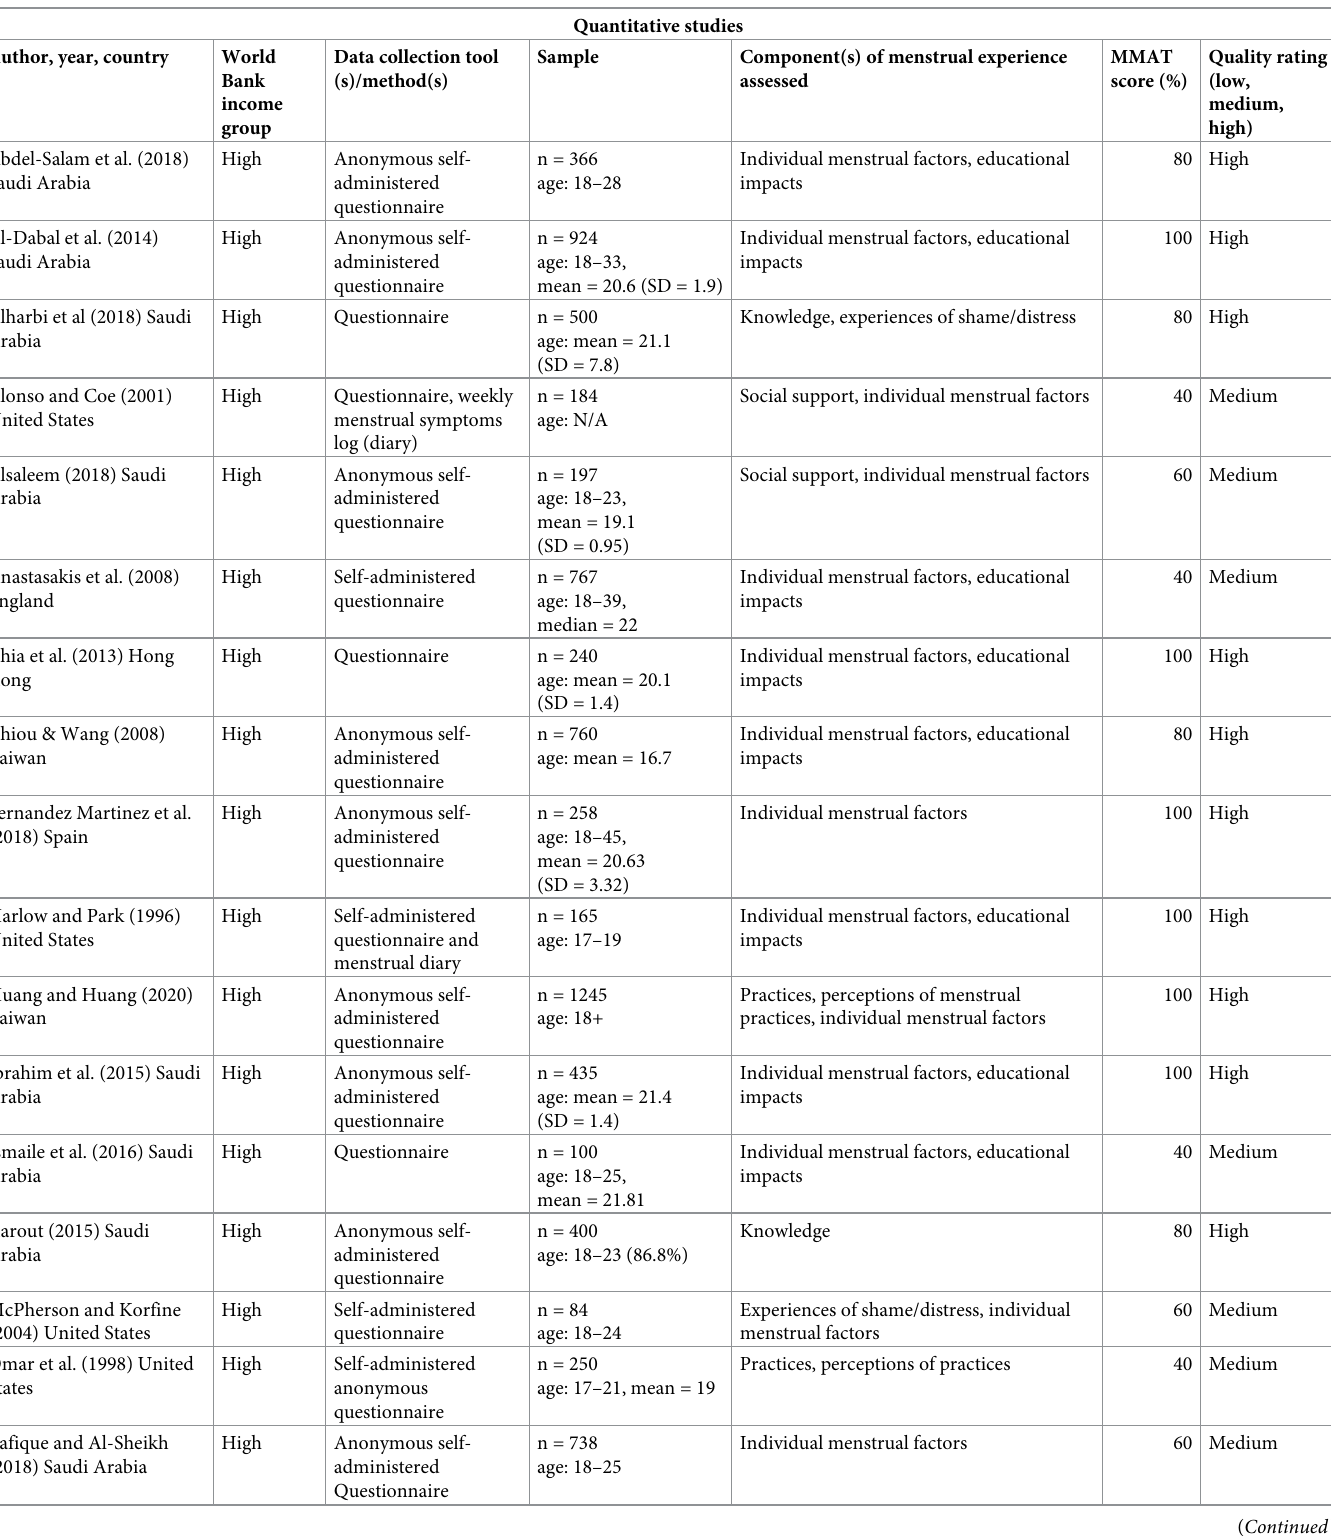
Table 2. Summary of included studies, component(s) of menstrual experience assessed, and quality assessment scores and